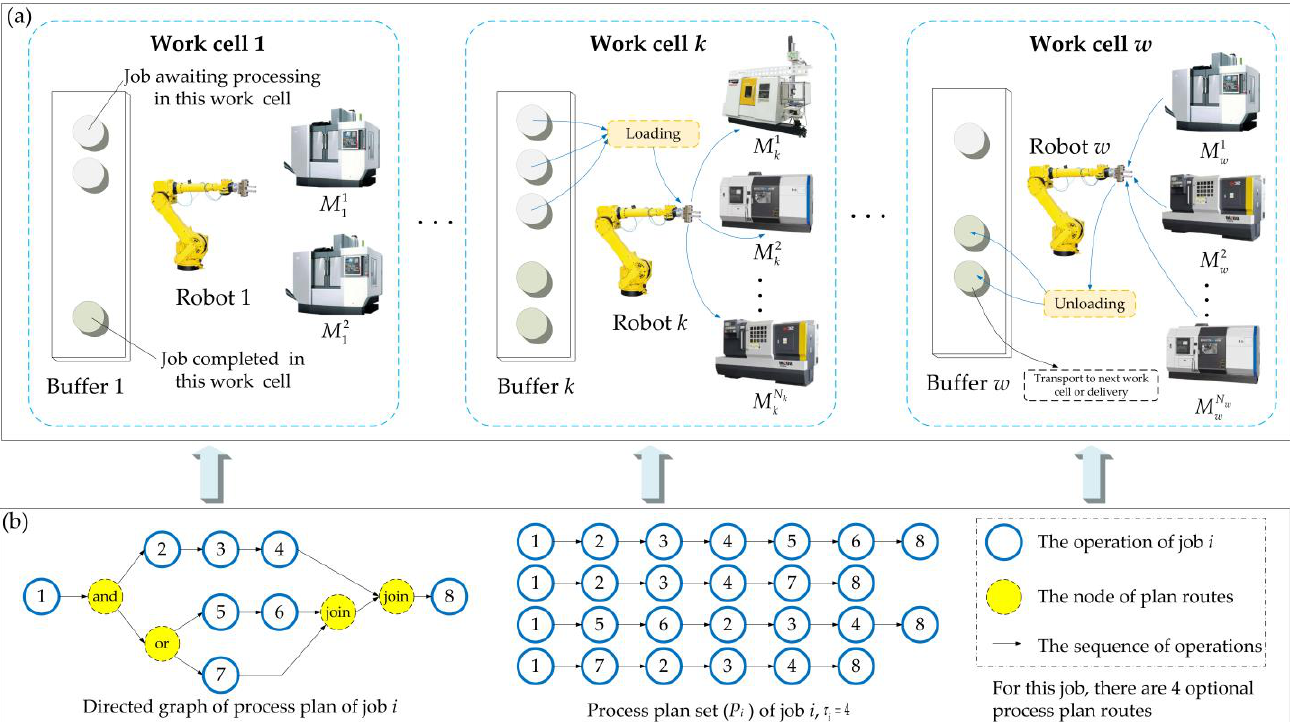
Figure 1. Composition of workshop: ( a ) schematic diagram of w work cells; ( b ) schematic diagram of process planning for a job.